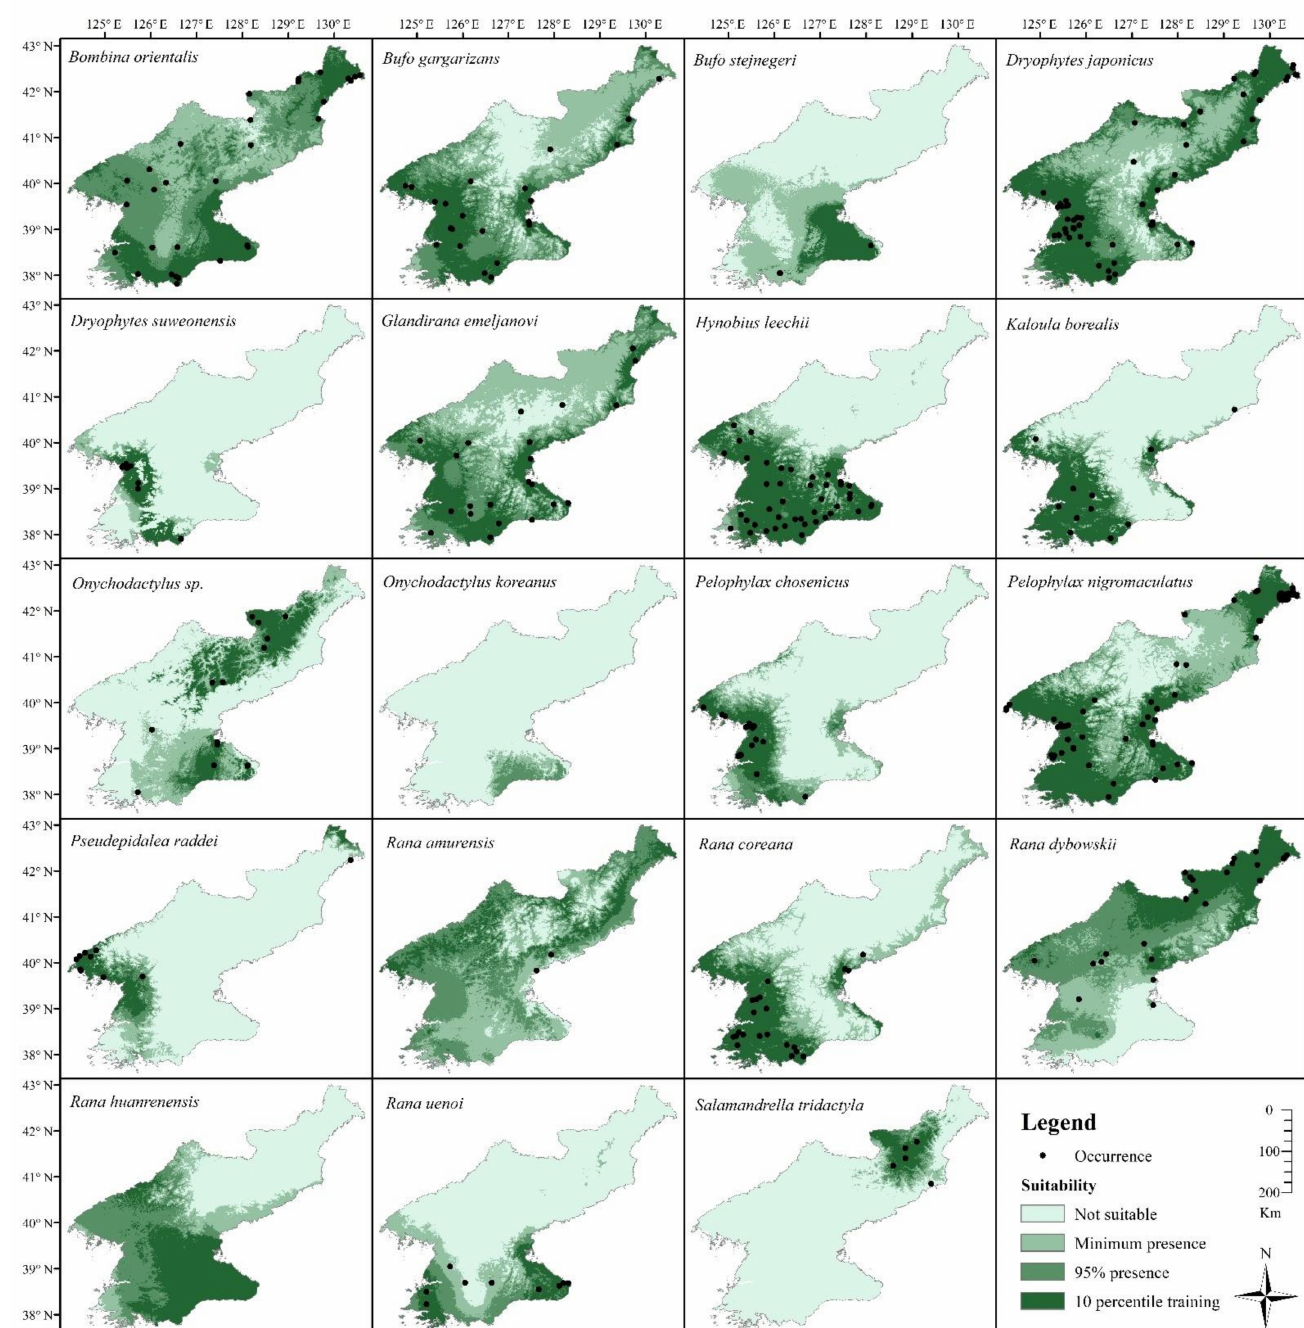
Figure 9. MaxEnt models for all amphibian species recorded in DPR Korea. Maps were created in ArcGIS 10.5 (ESRI; Redlands, CA,